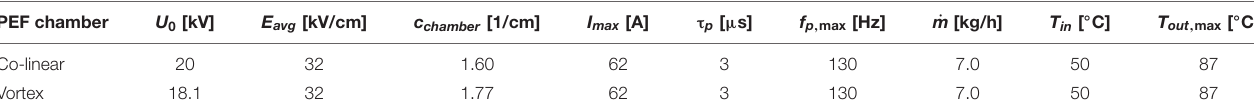
Frontiers in Bioengineering and Biotechnology |